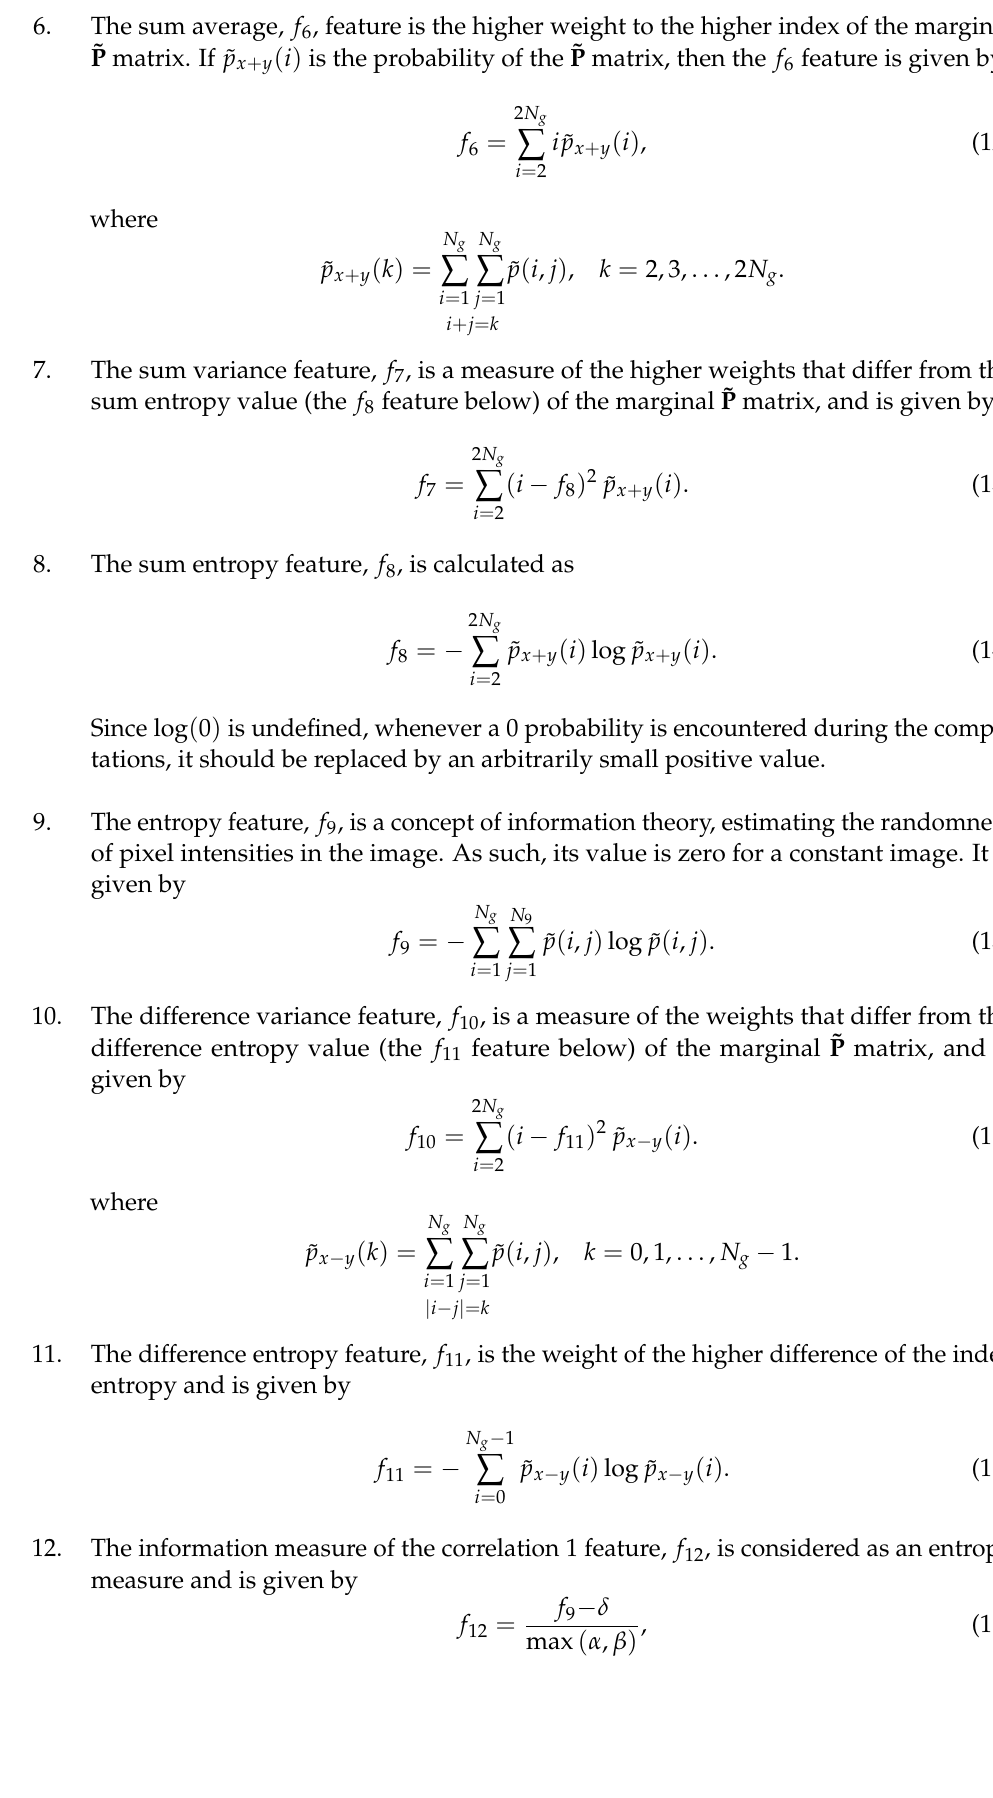
6. The sum average, f 6 , feature is the higher weight to the higher index of the marginal ˜P matrix. If ˜ p ( i ) is the probability of the ˜P matrix, then the f x + y